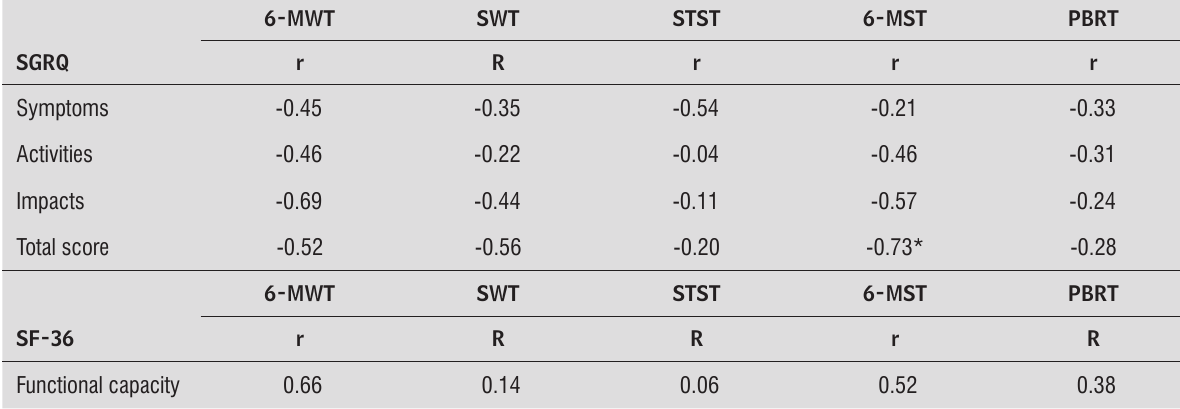
Table 4 - Correlation between functional capacity tests and the SGRQ and SF-36 questionnaires for the COPD group (n = 8)